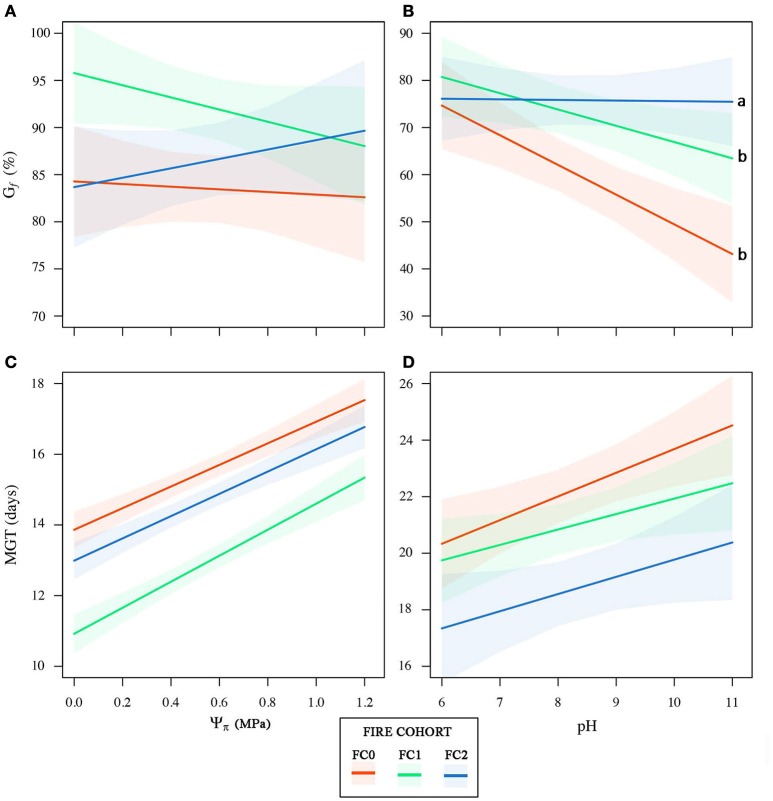
Cumulative germination percentage (Gf) and mean germination time (MGT) as a function of the osmotic potential (Ψπ, A,C) and pH (B,D) gradients for the three fire cohorts. 95% confidence bands for the linear models for each fire cohort are shown. Letters indicate significant differences between regression slopes according to z-test.